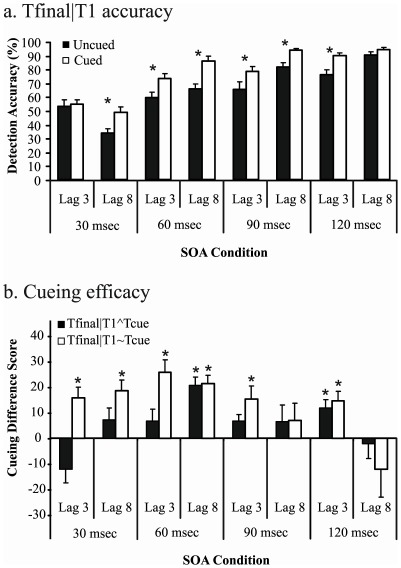
Target detection accuracy for Tfinal across every combination of lag and SOA.(a) displays Tfinal|T1 accuracy across cued and uncued trials. Asterisks indicate a significant difference between cued and uncued trials. Tfinal accuracy was significantly improved on cued trials for all comparisons except 30 msec/lag3 and 120 msec/lag8. (b) displays Tfinal cueing efficacy scores. These scores were conditionalised on T1 and the cue being correctly detected (Tfinal|TĺTcue) or on T1 being identified but Tcue being incorrectly detected (Tfinal|T1∼Tcue). A positive difference score indicates a benefit for cued trials over uncued trials. A negative difference score indicates a benefit for uncued trials over cued trials. Asterisks indicate a significant deviation from 0, where 0 represents equivalent accuracy across cued and uncued trials. Error bars show standard errors of the mean.